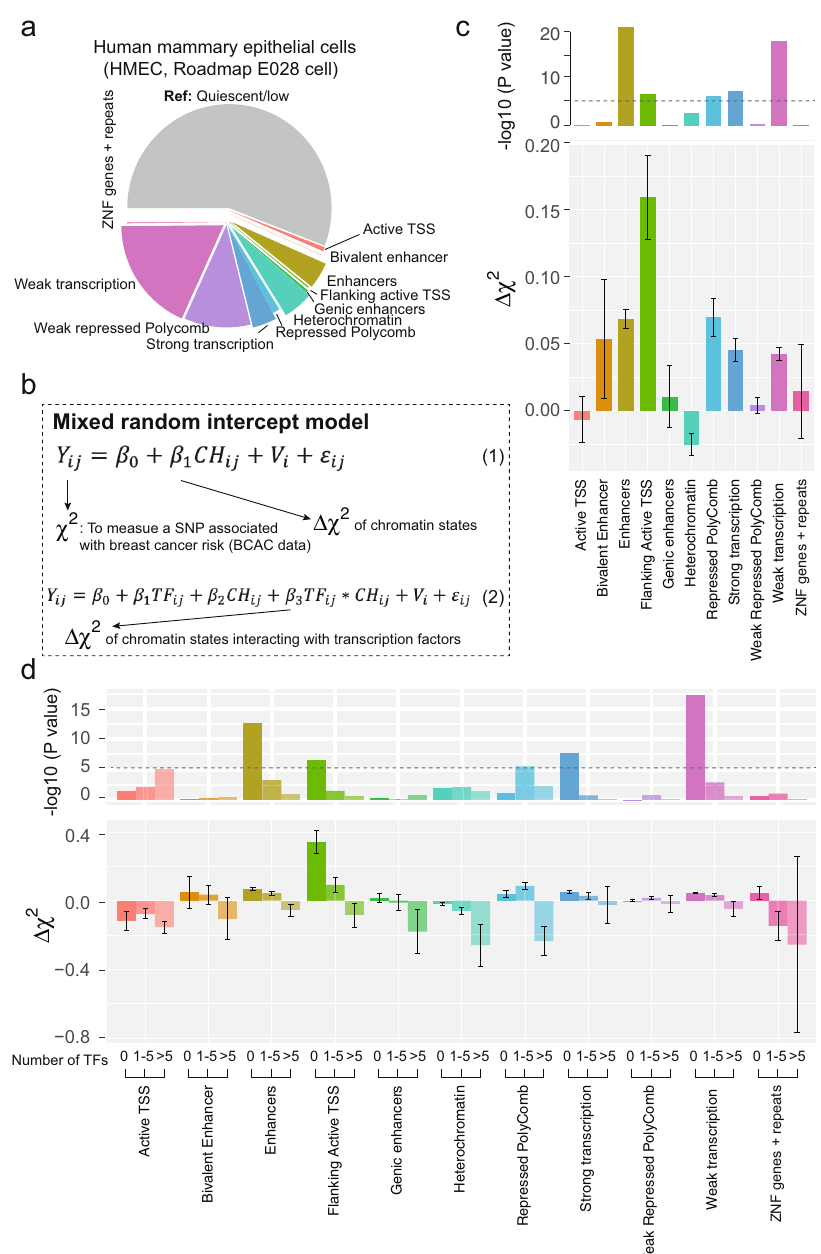
Fig. 4 TFs colocalizing with chromatin features associated with breast cancer risk. a Distribution of chromatin features annotated from chromatin states using the ChromHMM tool in breast human mammary epithelial cell (HMEC). Different colors denotes different chromatin states. b Mixed random intercept model constructed to evaluate associations of breast cancer risk with chromatin states using formula (1) and its interaction with TF-occupancy score using formula (2). c Barplots show the association of breast cancer risk with each chromatin feature (upper panel for P -values and lower panel for regression coef fi cients and standard errors). d Barplots show association with breast cancer risk for each chromatin feature (upper panel for P -values and lower panel for regression coef fi cients and standard errors), strati fi ed by TF scores. In these fi gures, the two-sided nominal P -values and 4 χ 2 were derived from the generalized mixed models and the error bars denote 95% con fi dence